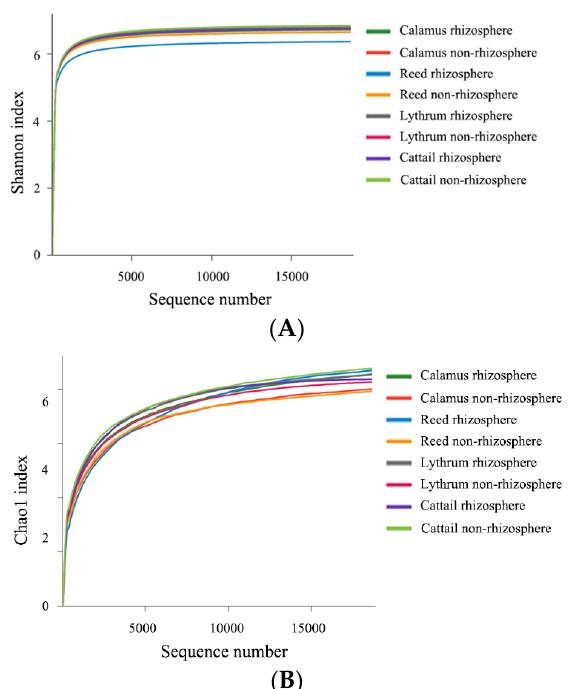
Figure 10. Shannon index dilution curve ( A ); Chao1 index dilution curve ( B ).